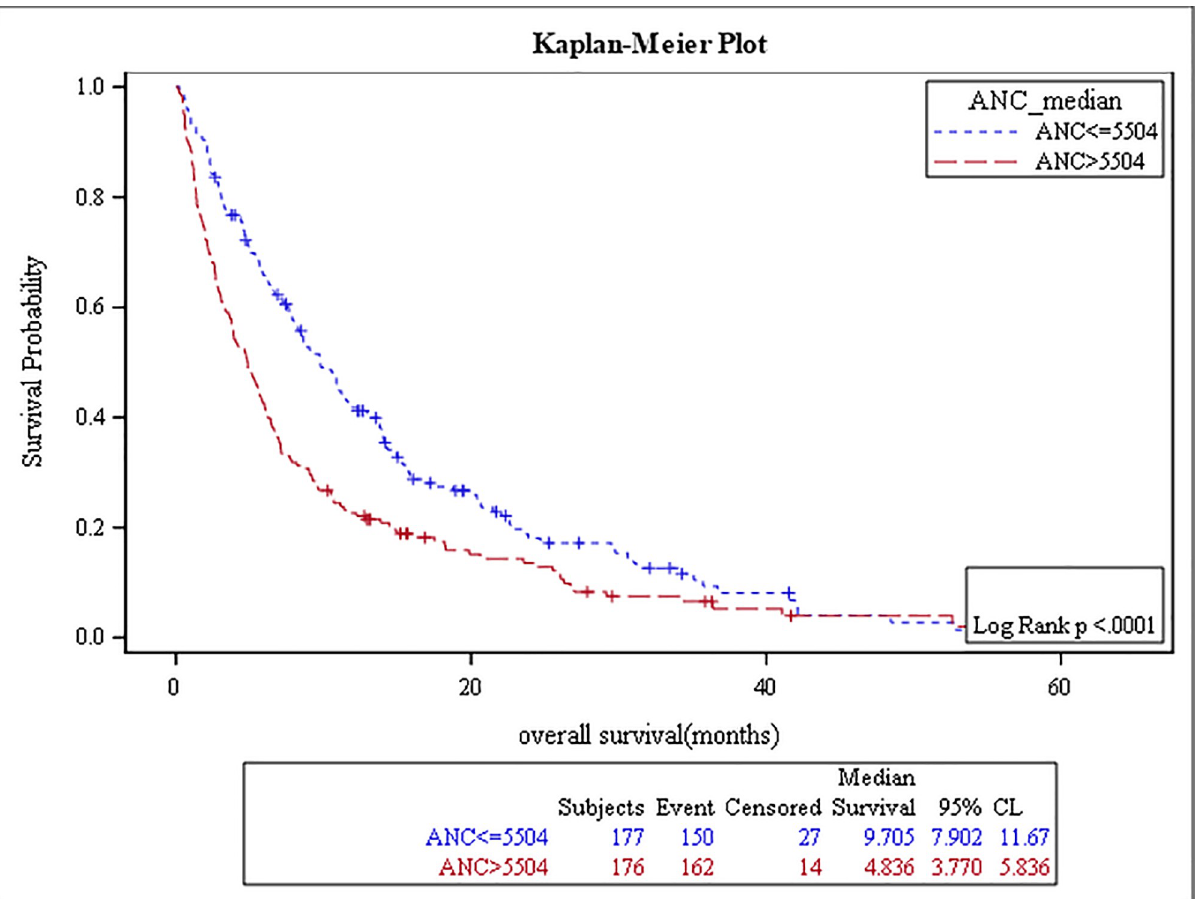
Fig 1. Kaplan Meier curve for overall survival for patients with ANC � 5500.